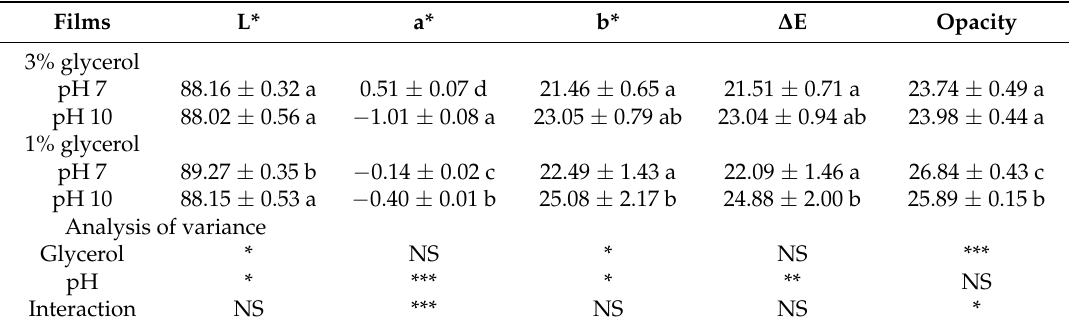
Table 2. CIE L*a*b* color parameters, total color difference ( ∆ E) and opacity of chickpea flour